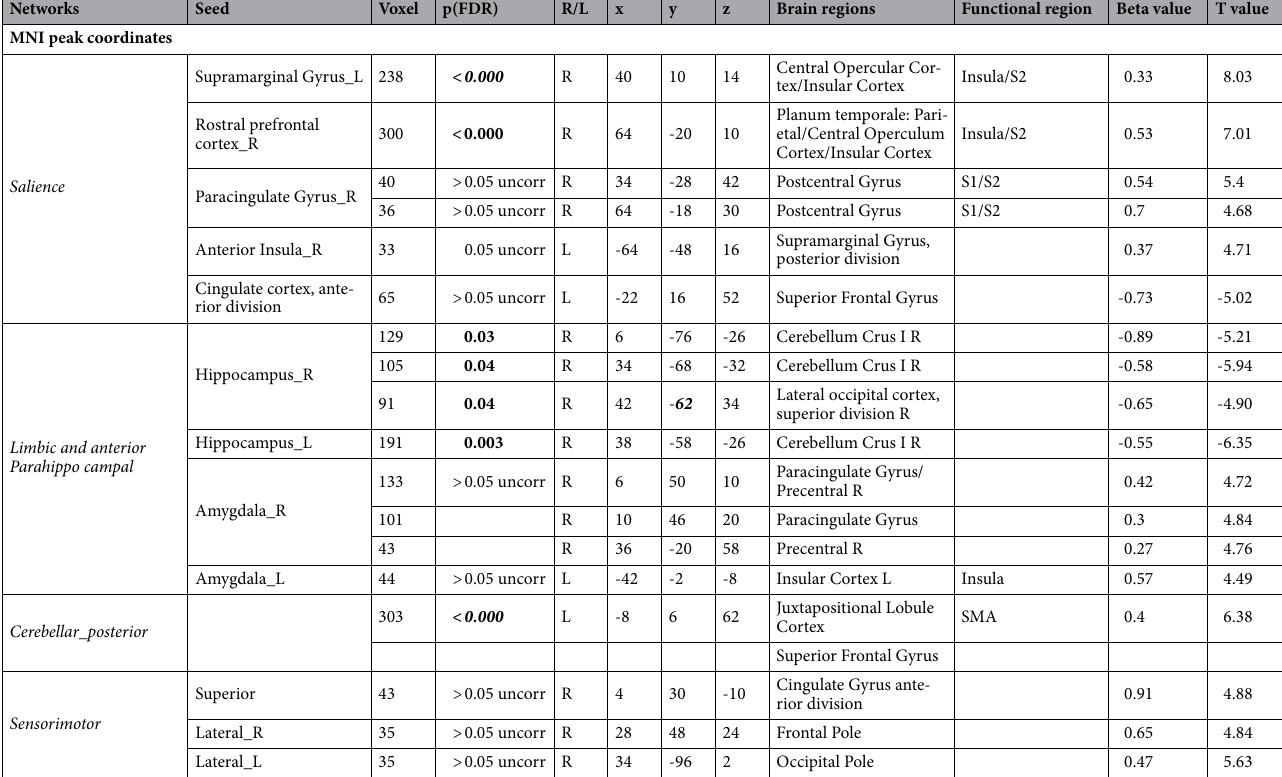
Table 2. Displayed are differences between patients with low back pain and a control group for locations of task-related functional connectivity of non-painful posterior to anterior intervertebral movement of the lumbar spine in long-ranging networks involved in sensorimotor